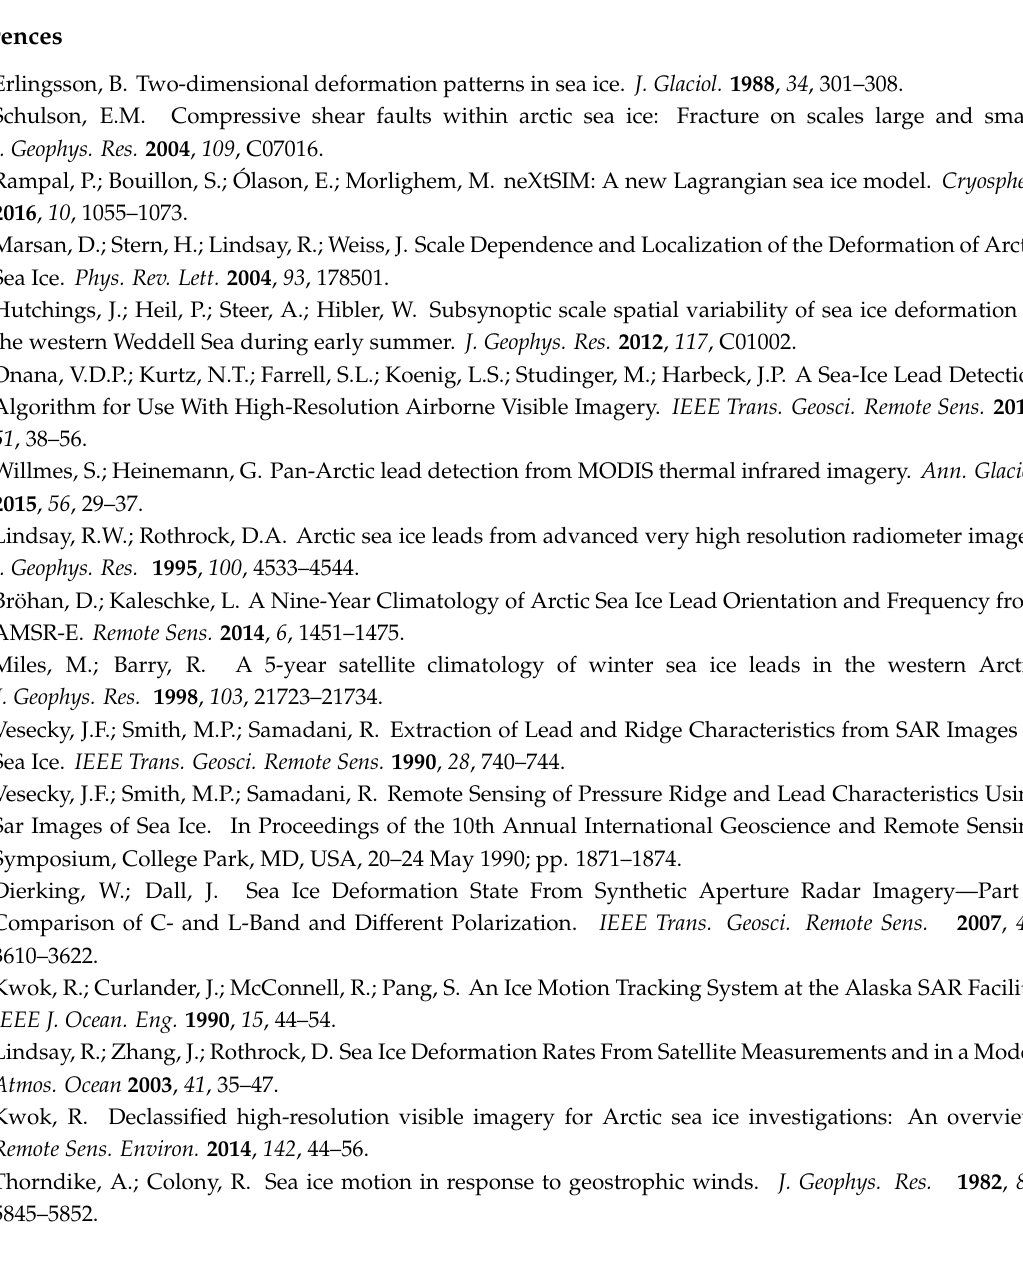
Figure A1. Cost function for intersection angle tolerance values ranging from 5 ◦ to 60 ◦ , in steps of 2 ◦ . The dotted line marks the 35 ◦